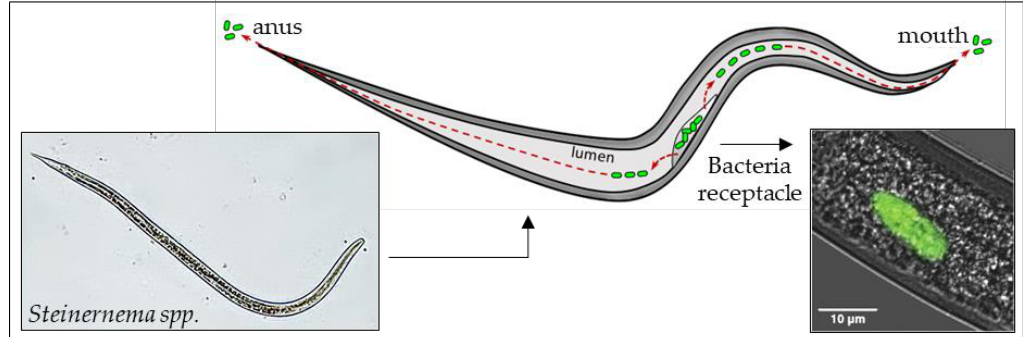
Figure 1. EPNs symbiotic bacteria ( Xenorhabdus spp.) live in a monoxenic area, or in differentiated vesicles of the anterior part of intestine, modified as a bacterial receptacle. Micrograph at right shows fluorescent GFP-transformed bacteria inside Steinernema spp. intestine, (image at right, courtesy of J. Chaston, from [25]) .